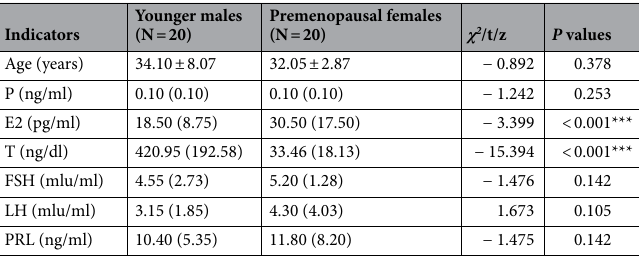
Table 2. Comparison of gonadal hormones between younger males and premenopausal females. * P < 0.05, ** P < 0.01, *** P < 0.001.